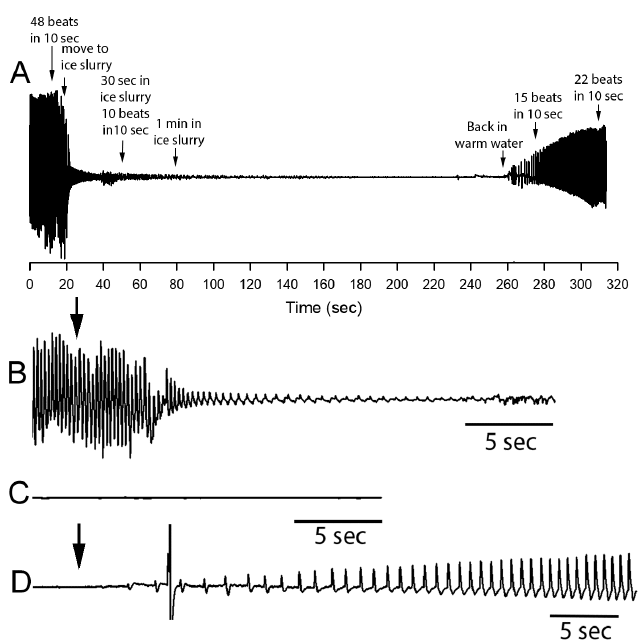
Figure 3. Representative electrocardiography (ECG) trace obtained from a shrimp (Belize cohort) while